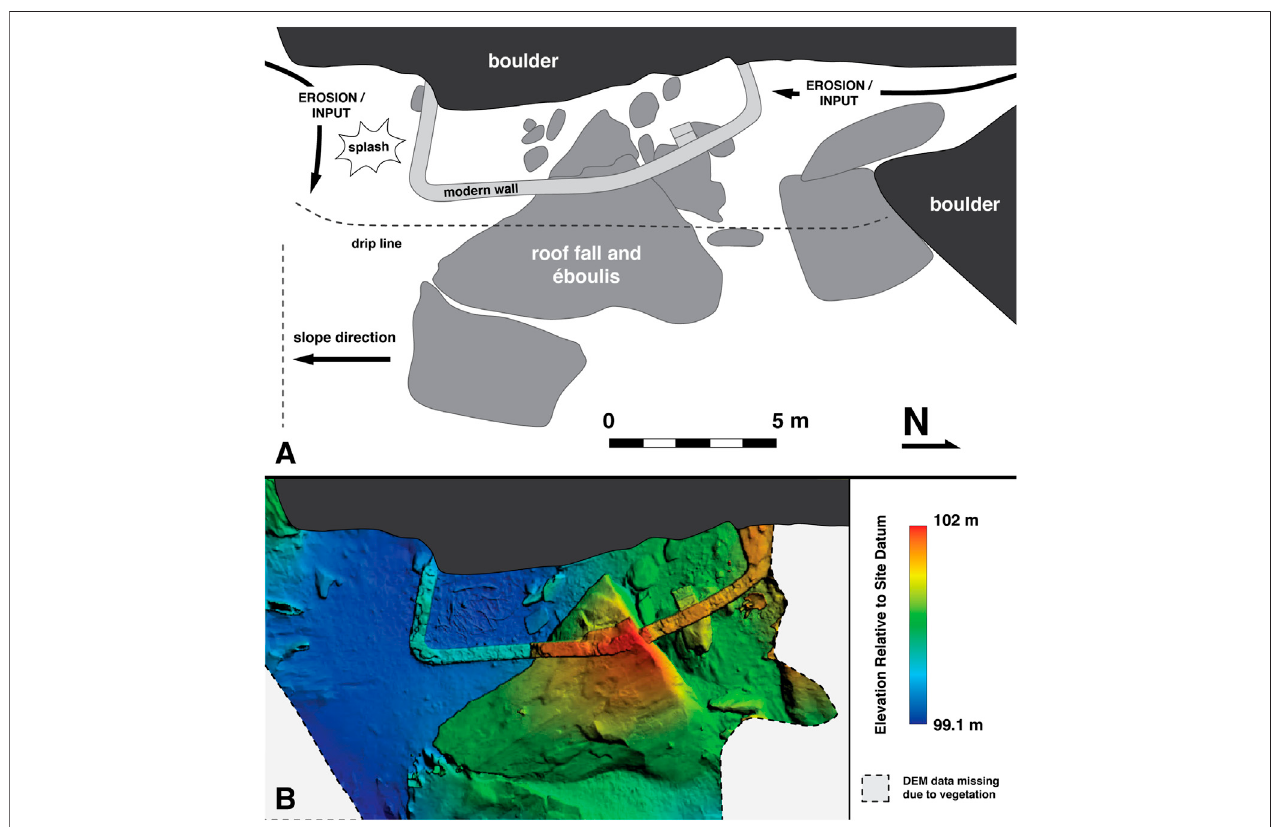
FIGURE7| Diagramsoftherockshelterinplan view fromabove. North arrow indicates grid north. (A) thedifferent processes weidenti fi ed: combinationoferosion and sedimentation is visible especially at the S and N edges of the boulder; Splash erosion is present along the dripline and in circumscribed areas. As shown in the diagram, the majority of the sediments are protected by the rock slabs. (B) Digital elevation model generated from a photogrammetric model produced in Agisoft Metashape. Elevation units are relative to site datum. Note the difference in elevation between the northern and the southern portion.